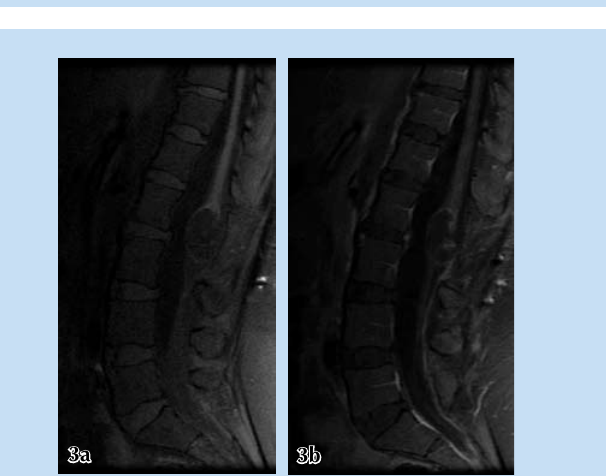
Fig. 1. Unenhanced sagittal MRI with T1-weighted (Fig. 1a), T2-weighted (Fig.1b) and T2-weighted (Fig. 1c) sequences.